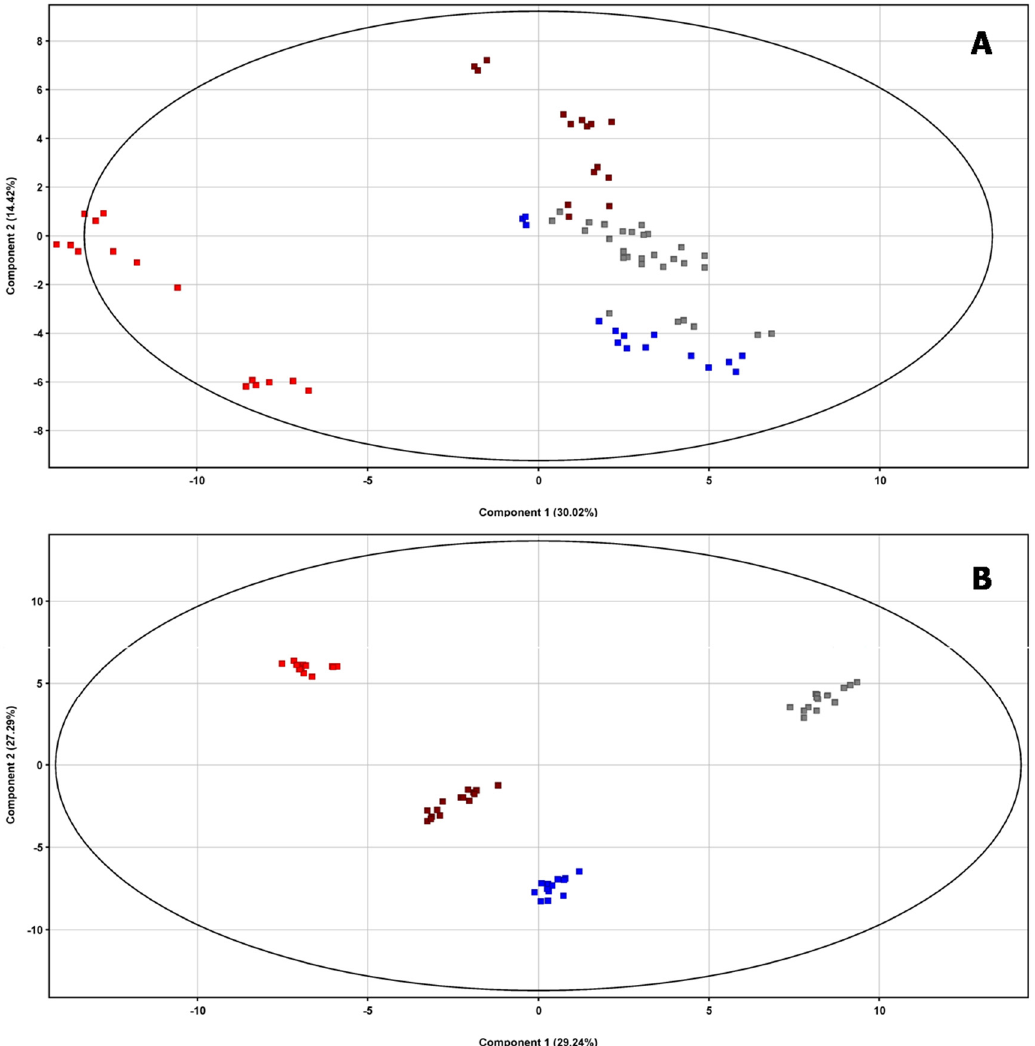
Figure 3. Principal components analysis (PCA) score plots of the LC-MS data acquired for positive ( A ) and negative ( B ) mode. Each group of replicates subjected to different treatments is depicted with a different color: control group (C) is red; Streptomyces group (S) is blue; Trichoderma group (T) is grey; microbial consortium (S + T) is brown.